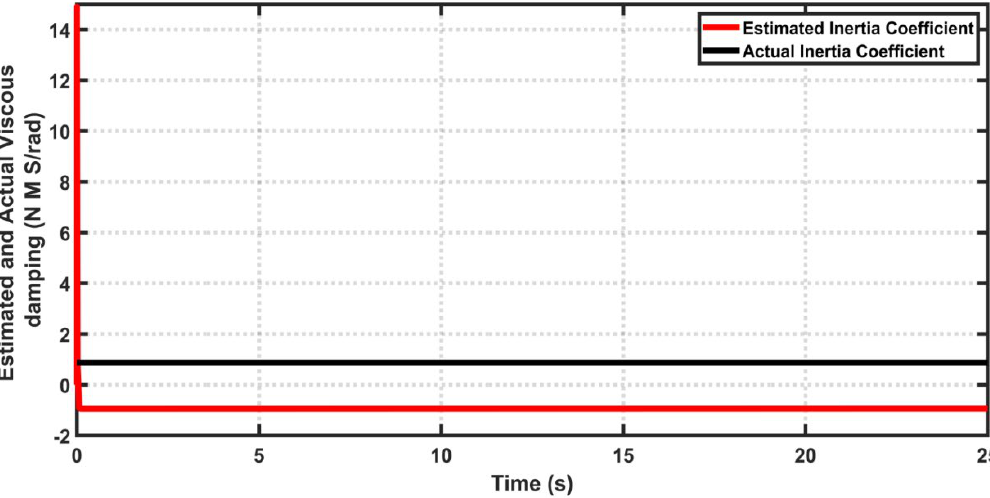
. . . 𝑓𝑓 𝑣𝑣 𝑓𝑓 𝑣𝑣 𝑓𝑓 𝑣𝑣